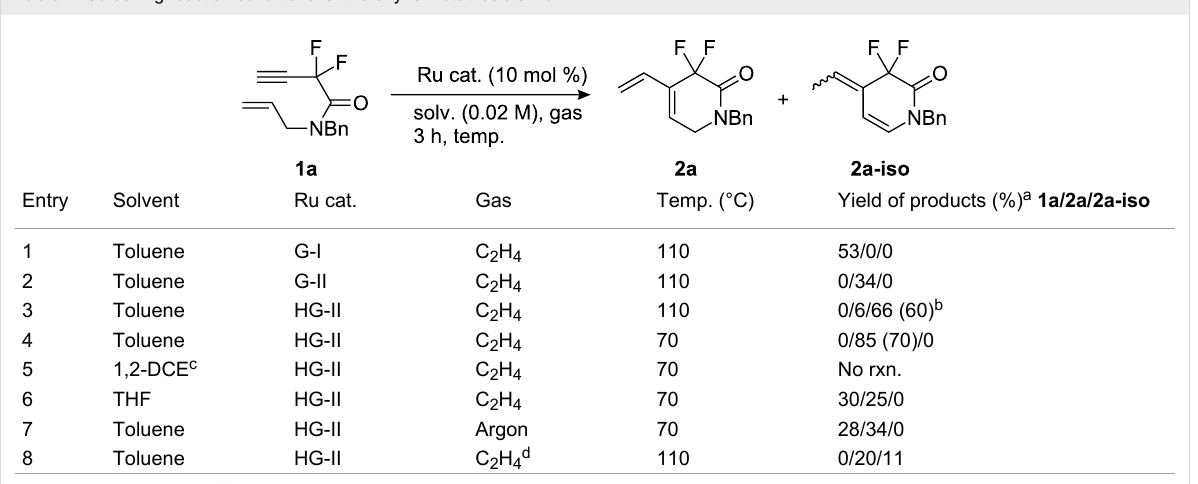
Table 1: Screening reaction conditions for the enyne metathesis of 1a .